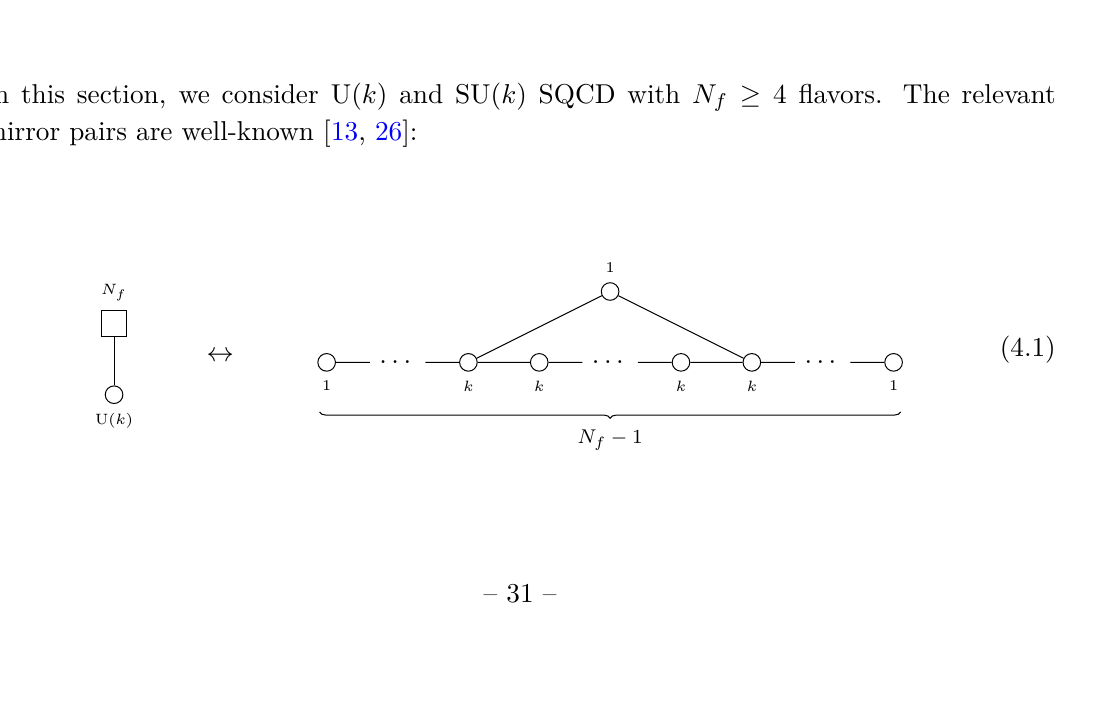
Figure 9 . Given an FI deformation ζ 0 one can look for free quiver solutions, shown here in red. They can happen to be extremal (as is the case here for S free can be used as seeds to restrict the space of potential extremal solutions to explore to the solutions that lie below the free